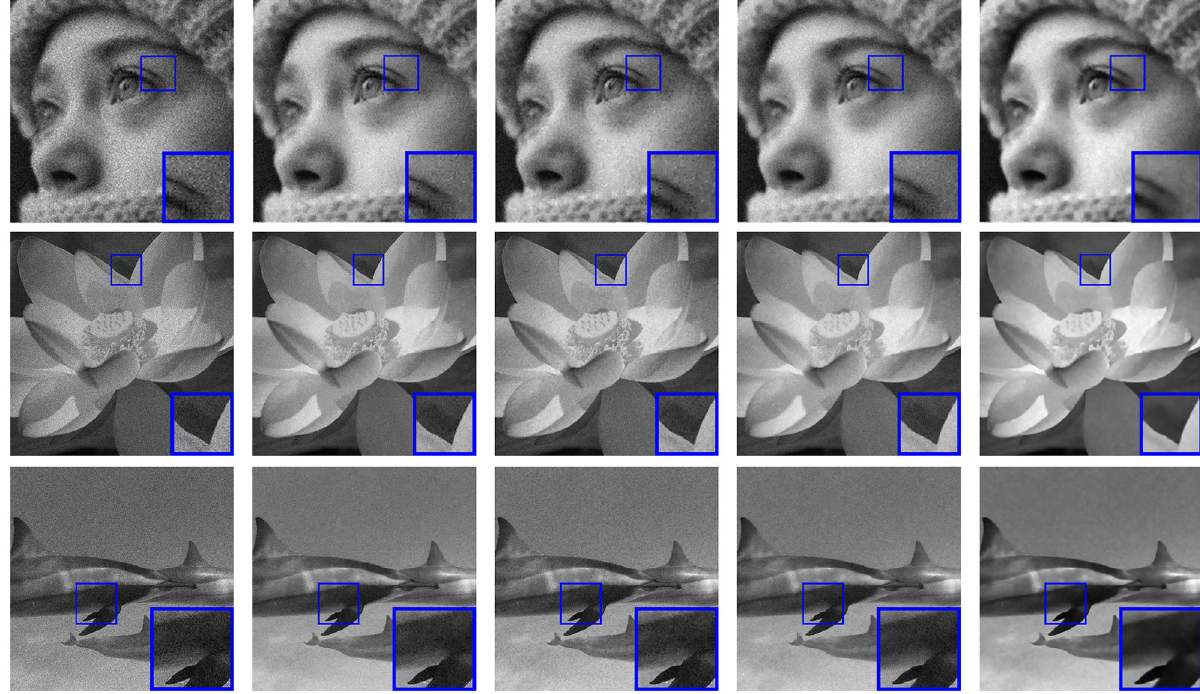
Fig 3. Denoised images and a zoom-in region from the Poisson noisy images with the noise level MAX f = 100. first column: Poisson noisy images; second column: denoised images by SB-FA [38]; third column: denoised images by SAHTV [5]; fourth column: denoised images by FT-ADMM [37]; fifth column: denoised images by